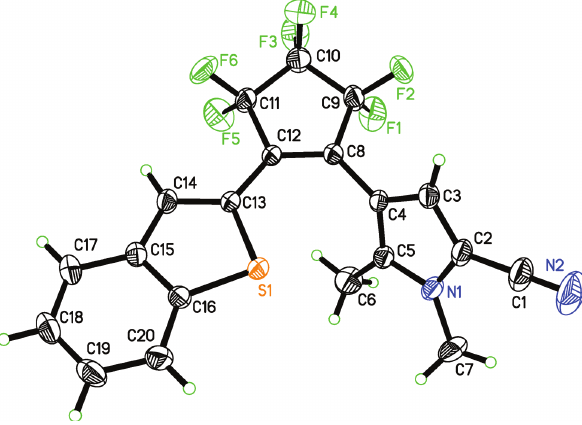
Table 2: Fractional atomic coordinates and isotropic or equivalent isotropic displacement parameters (Å 2